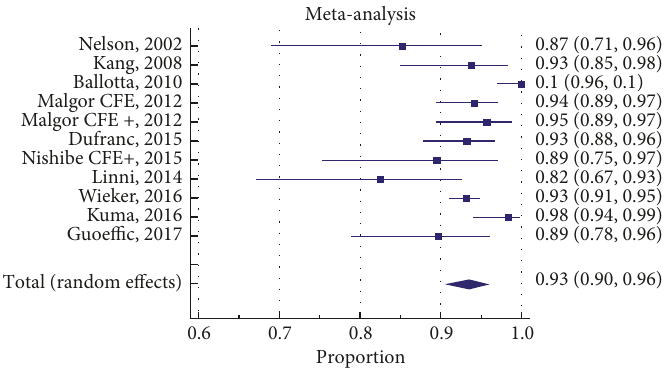
mortality at 30 days in CFE group: symmetrical. Figure 22: Forrest plot for local complications in EVTSS group. Figure 23: Funnel plot for local complications in EVT SS group: symmetrical. Figure 24: Forrest plot for local complications in EVT RS group. Figure 25: Funnel plot for local complications, EVTRS group: symmetrical. Figure 26: Forrest plot for local complications in CFE group. Figure 27: Funnel plot for Local complications in CFE group: asymmetrical. Figure 28: Forrest plot for amputations in EVT SS group. Figure 29: Funnel plot for amputations in EVT SS group: symmetrical. Figure 30: Forrest plot for amputations in EVT RS group. Figure 31: Funnel plot for amputations in EVT SS group: symmetrical. Figure 32: Forrest plot for amputations in CFE group. Figure 33: Funnel plot for amputations in CFE group: asymmetrical. Figure 34: Forrest plot for mortality at max follow-up in CFE group. Mortality was 23.1% (95% CI 0.14- 0.33). Figure 35: Forrest plot for mortality at max follow- up in EVT-RS group. Mortality was 5.33% (95% CI 0.016- 0.11). Figure 36: Forrest plot for mortality at max follow-up in EVT-SS group. Mortality was 10.9% (95% CI